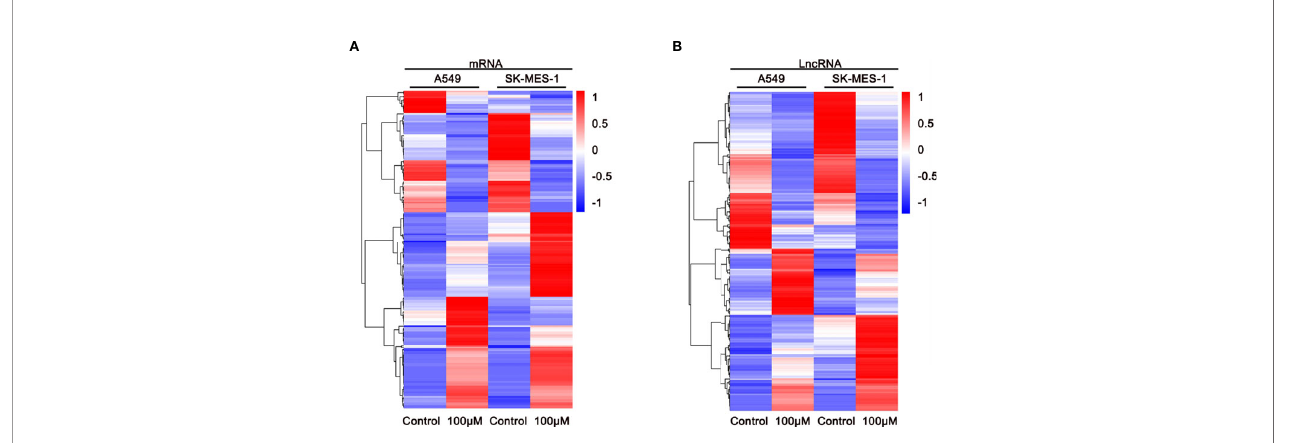
FIGURE 7 | Expression pro fi les of DE-mRNAs are in fl uenced by ivosidenib. Heatmap showing expression pro fi les of differentially expressed mRNAs (A) and lncRNAs (B) between NSCLC cells and ivosidenib-treated NSCLC cells.